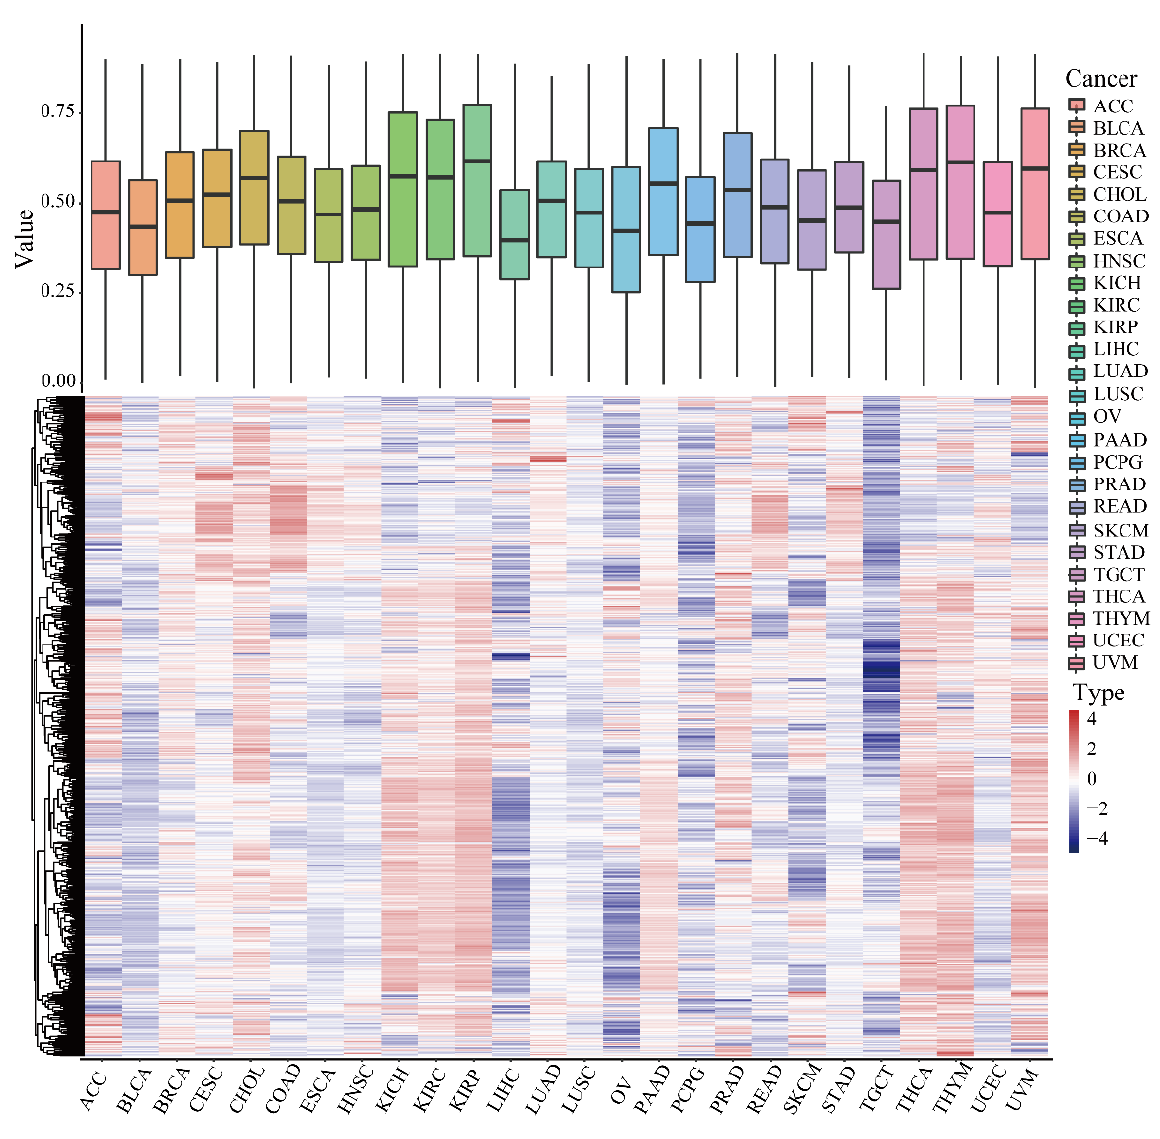
Figure 1. The overview of DNA methylation of G protein-coupled receptors in pan-cancer. The bars in the upper half represents the distribution of DNA methylation values of all samples in each cancer, and the heatmap in the lower half shows the DNA methylation levels of GPCRs-related genes in different cancer types.